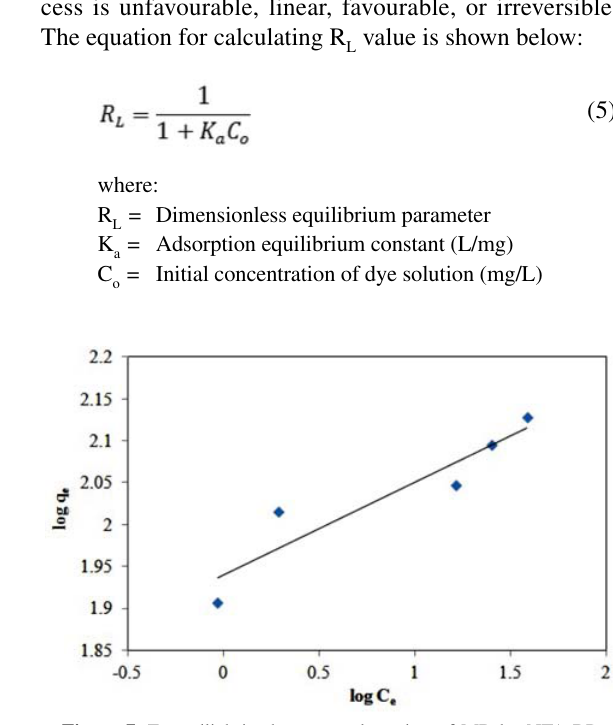
Figure 7. Freundlich isotherm on adsorption of MB by NTA-BP (Condition: 0.02 g of adsorbent in 20 mL of 100, 125, 150, 175, 200 mg/L MB dye solution at 150 rpm for 6